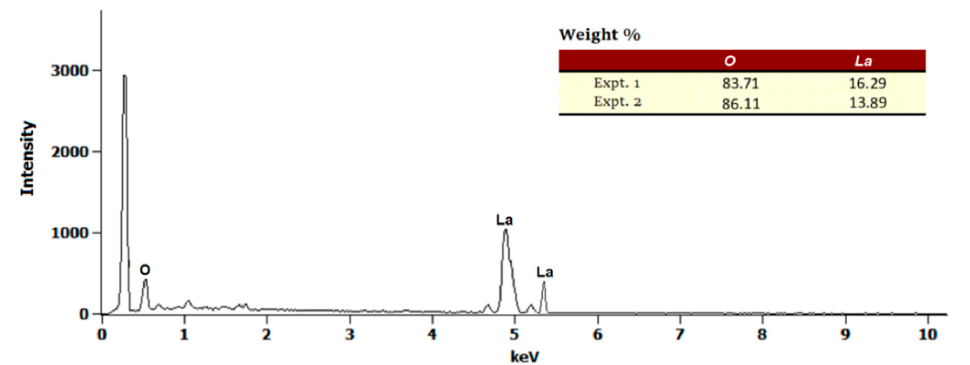
Figure 4. Energy dispersive X-ray spectrum of chitosan-La 2 O 3 (15 wt%).